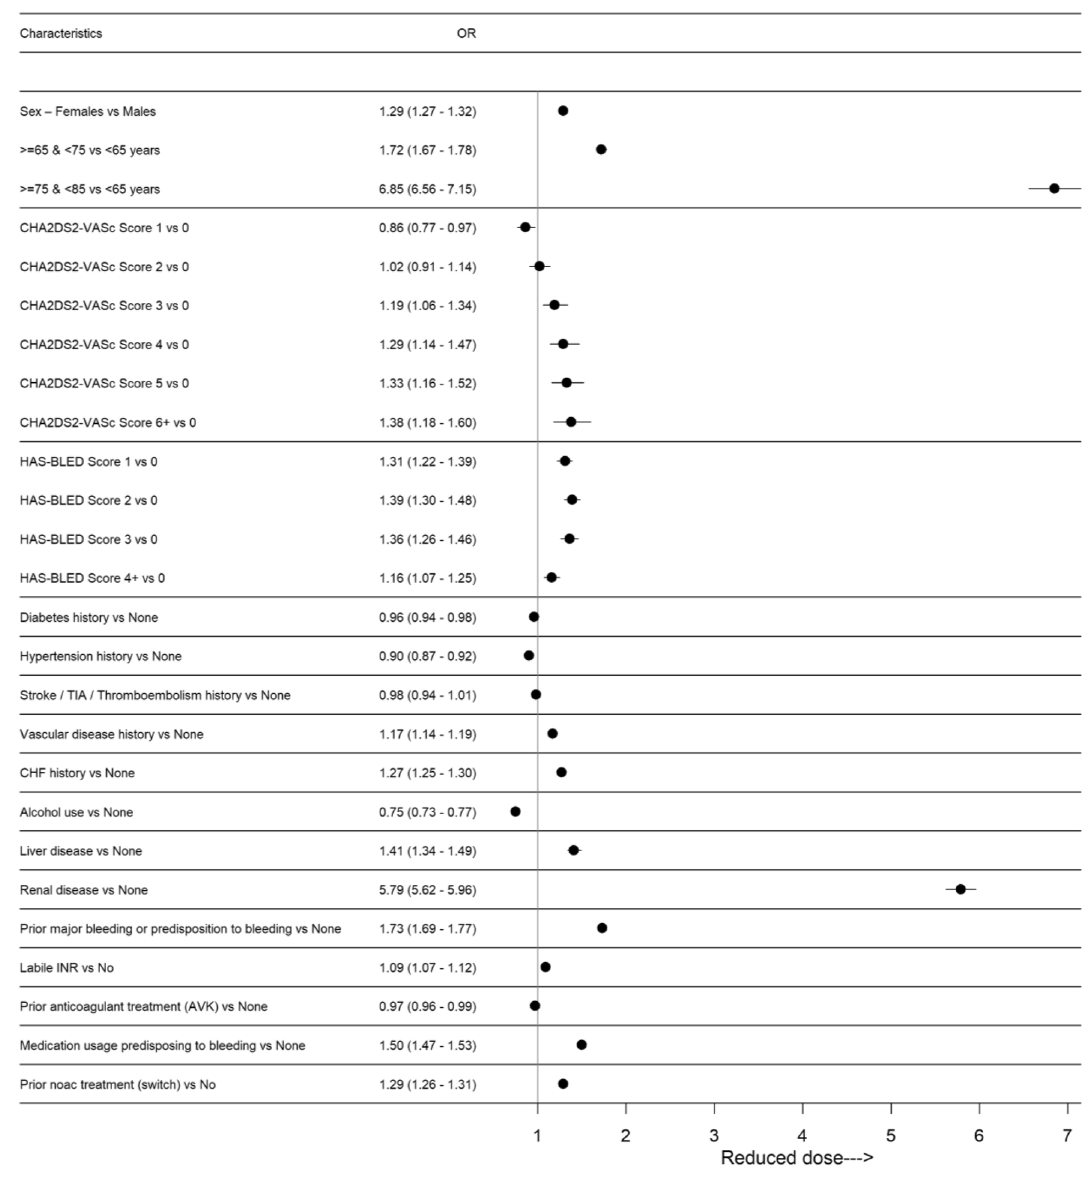
Figure 1. Association between baseline characteristics and choice of reduced dose of NOACs at first prescription in 866,539 patients enrolled in AIFA Registry (2013–2018). Data are expressed as odds ratio and confidence intervals for the baseline characteristics. For visual purposes, the odds ratio associated for age class 85 + (OR 27.22 26.03–28.46, reference < 65 years old) is not shown. Plot has been made using the statistical software R 8 and the forestplot package 10